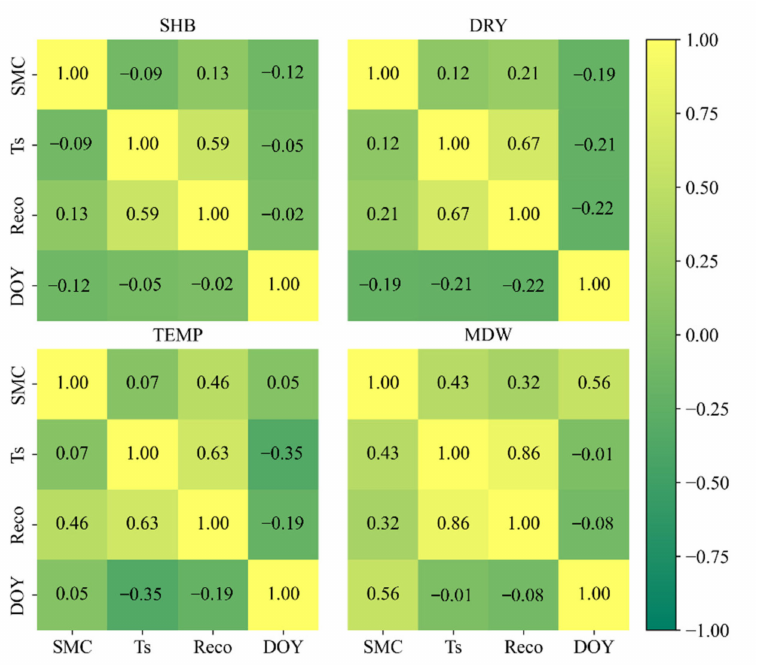
Figure 8. The correlation coefficient (r) values among variables of soil moisture content (SMC), soil temperature (Ts), day of year (DOY) and ecosystem respiration (R eco ) at SHB, DRY, TEMP, and